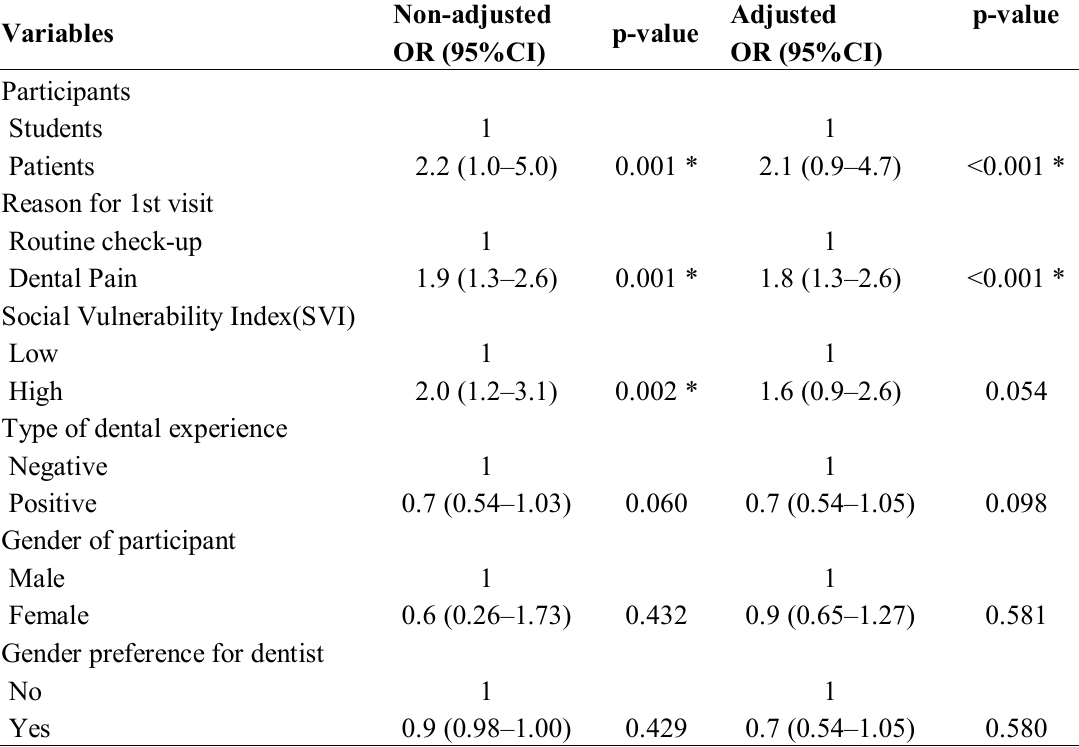
Table 2. Multinomial logistic regression model regarding presence of dental fear and other exogenous